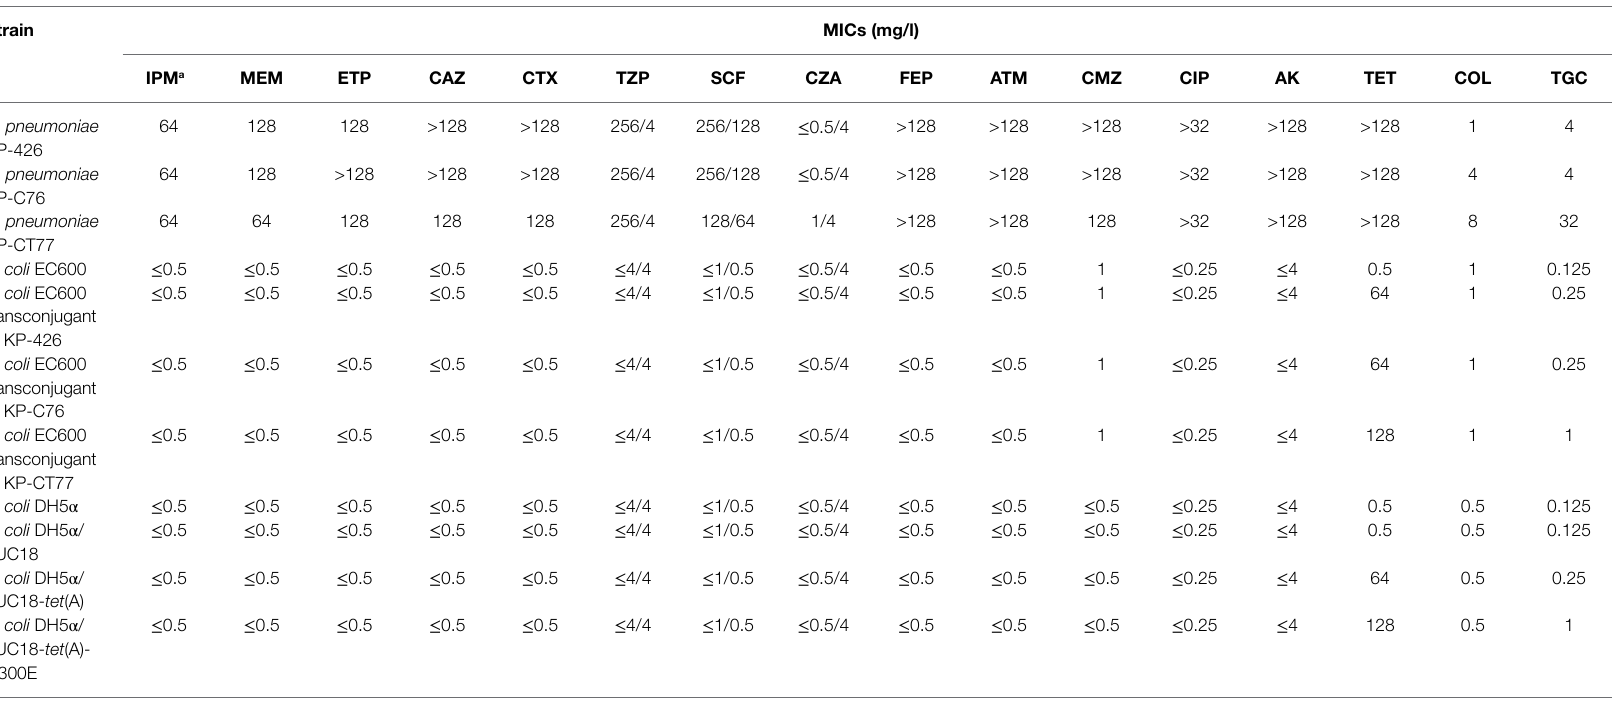
TABLE 1 | Antimicrobial susceptibility results of three clinical Klebsiella pneumoniae isolates and their E. coli transconjugants and transformants.